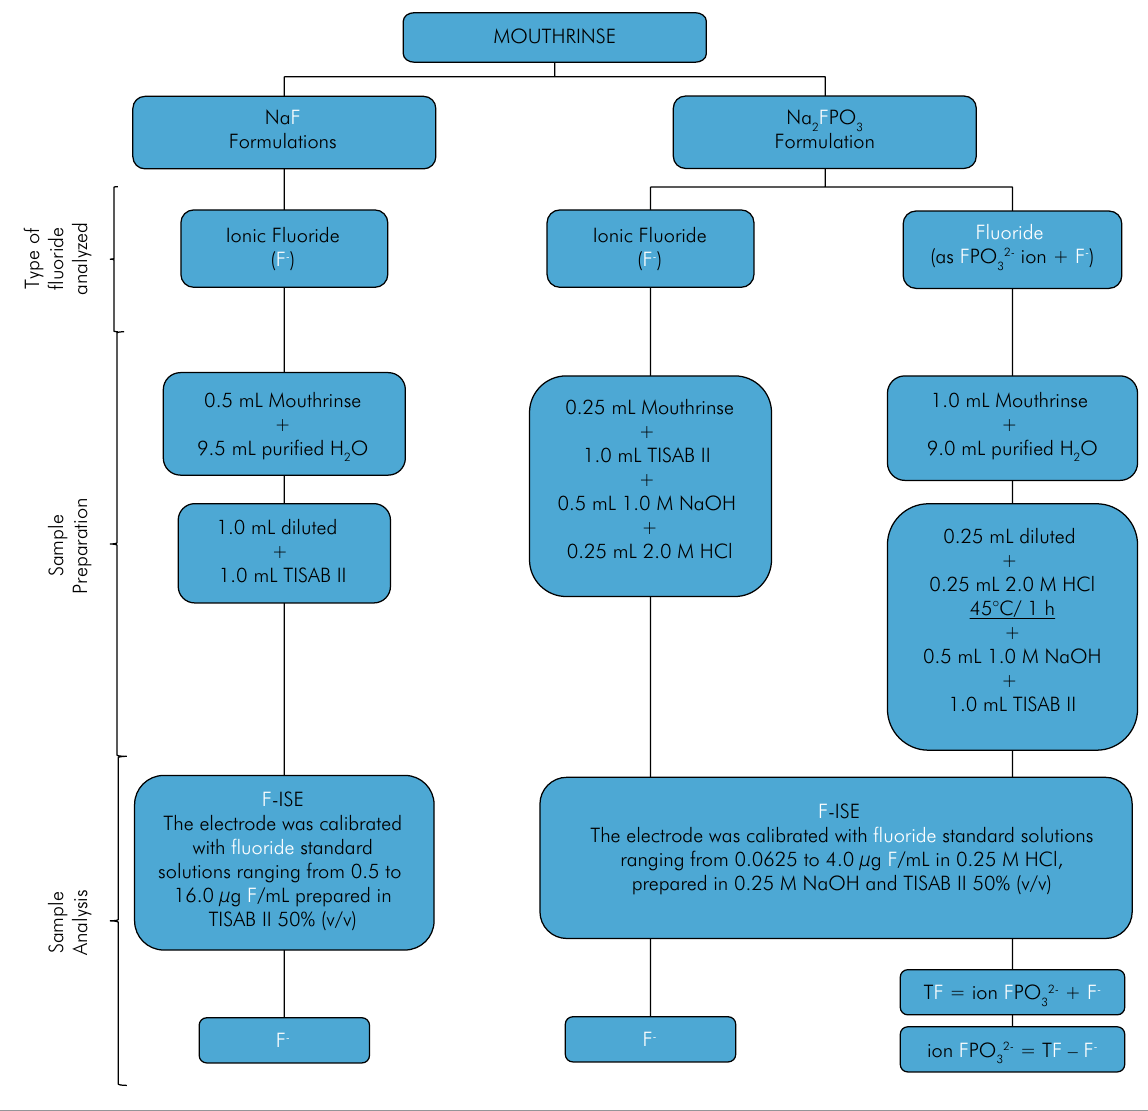
Figure. Diagram of NaF and Na